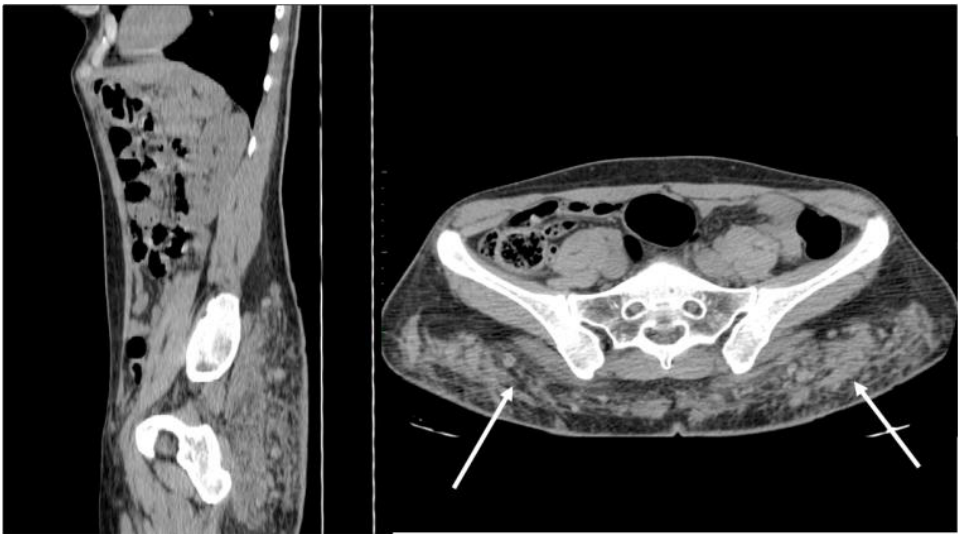
Figure 13. Non-enhanced sagittal and axial CT scan demonstrates free silicon material scattered with an infiltrative appearance, expanding all along the subcutaneous fat of the posterior abdominal wall (arrows). Strand-like lesions coexist with nodular and plaque-like areas, making the differential diagnosis with neoplastic conditions difficult.